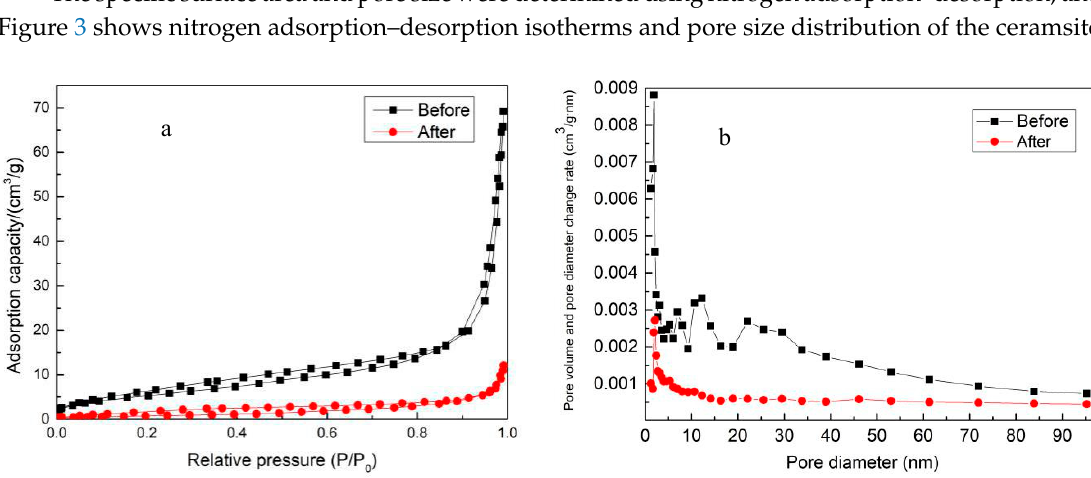
Figure 3. Nitrogen adsorption–desorption isotherms ( a ) and pore size distribution ( b ) of ceramsite.